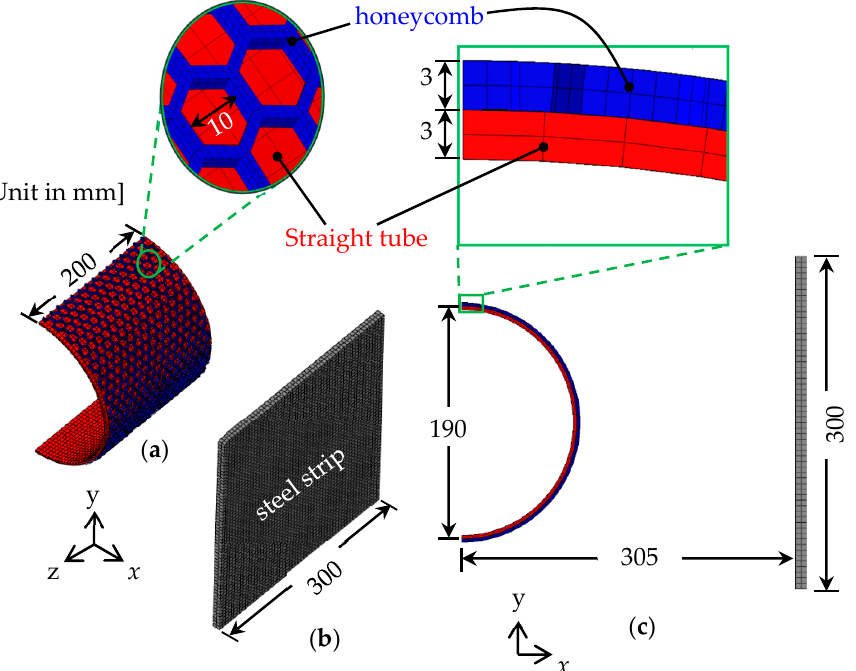
Figure 3. ( a ) Isometric view of the partial FE model ( b ) Steel trip ( c ) Front view of the partial FE model.